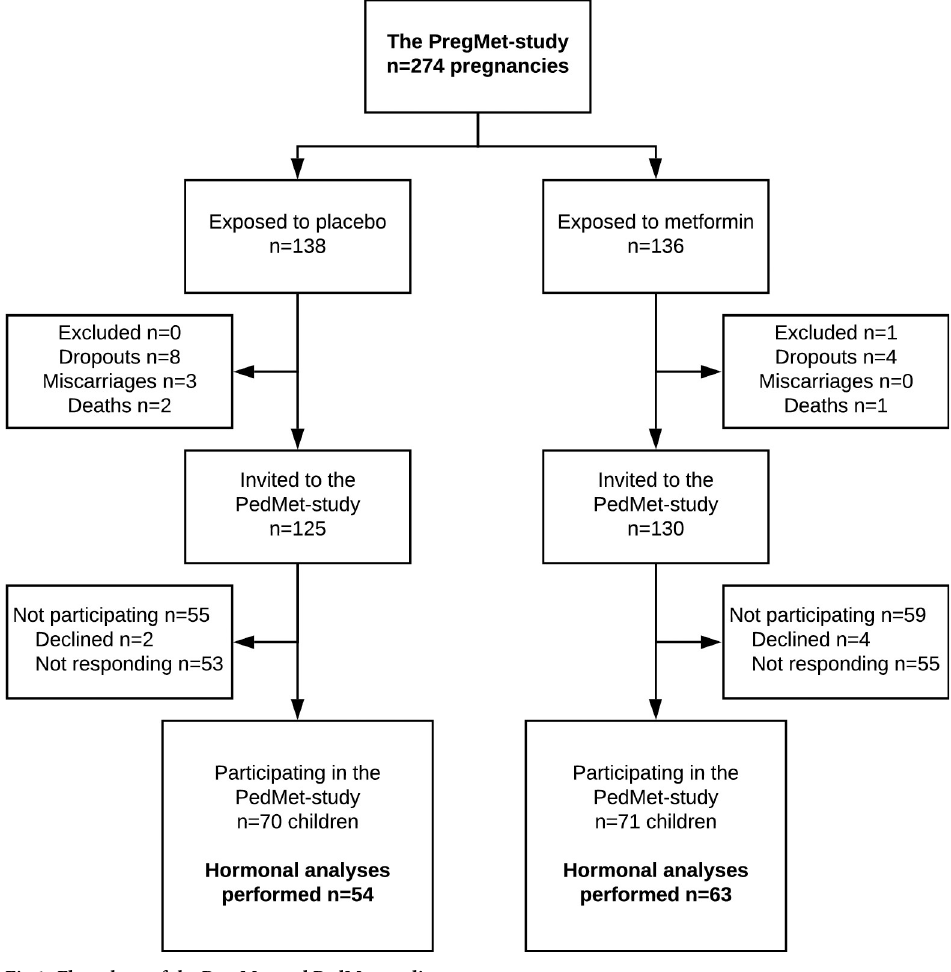
Fig 1. Flow chart of the PregMet and PedMet